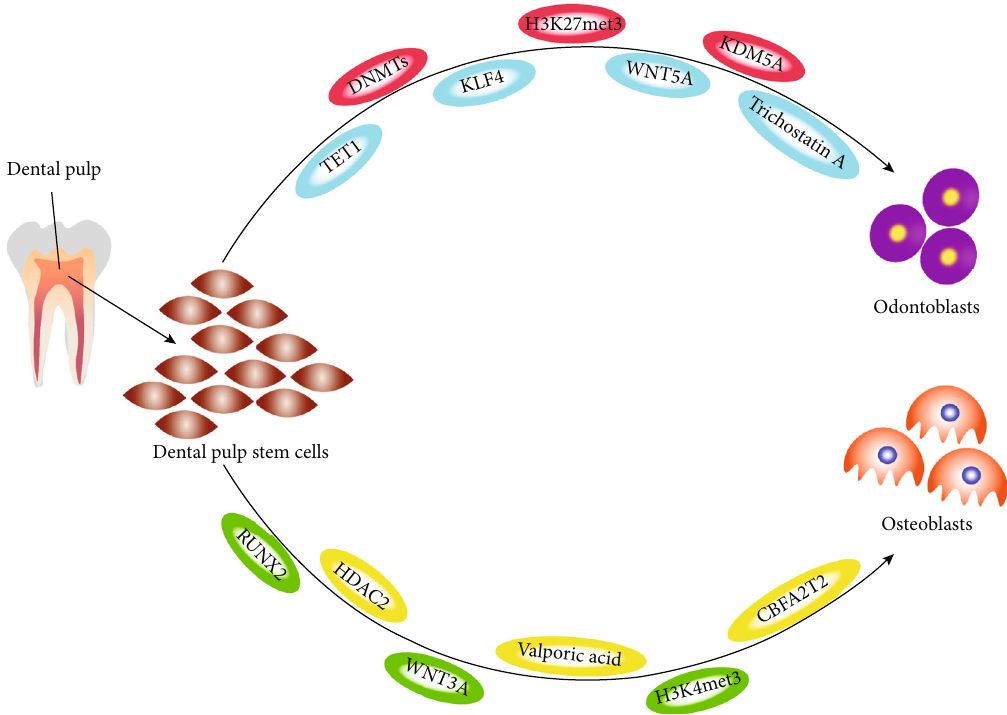
Figure 2: The pathways of dental pulp stem cell (DPSC) di ff erentiation. Yellow and red ovals block di ff erentiation pathways, and green and blue ovals stimulate the di ff erentiation of DPSCs. Abbreviations: DNMTs: DNA methyltransferases; TET: ten-eleven translocations; H3K27met3: histone H3 lysine 27 trimethylations; H3K4met: histone H3 lysine 4 trimethylation; KDM5A: lysine demethylase 5A; HDAC2: histone deacetylase 2; KLF4: Krüppel-like factor 4; WNT5A: Wnt family member 5A; WNT3A Wnt family member 3A; RUNX2: runt-related transcription factor